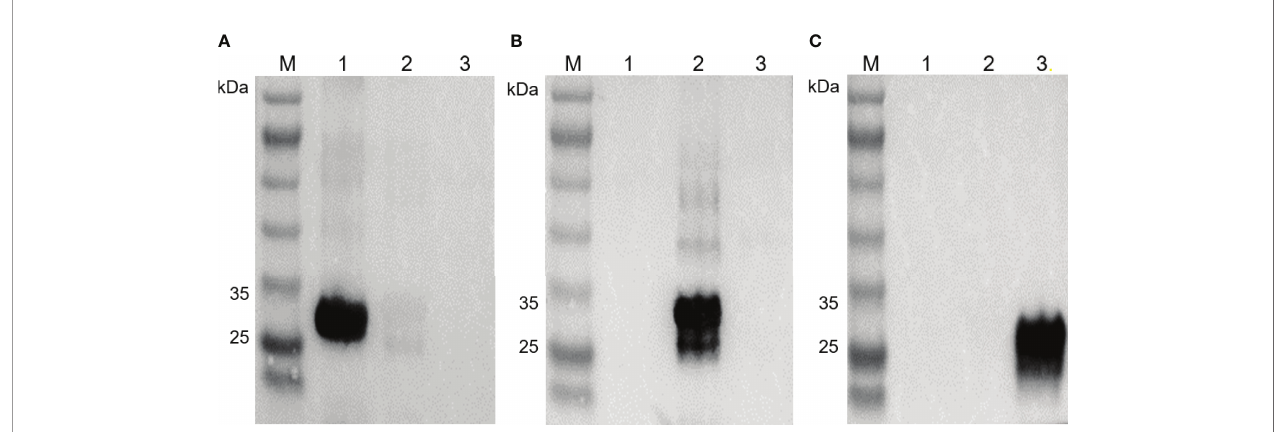
FIGURE 3 | Western blot of recombinant EbSWP1, EbSWP2 and EbSWP3. (A) Western blot analysis of recombinant EbSWPs with anti-EbSWP1 pAb. Lane M: protein molecular weight marker; lane 1: EbSWP1; lane 2: EbSWP2; lane 3: EbSWP3. (B) Western blot analysis of recombinant EbSWPs with anti-EbSWP2 pAb.